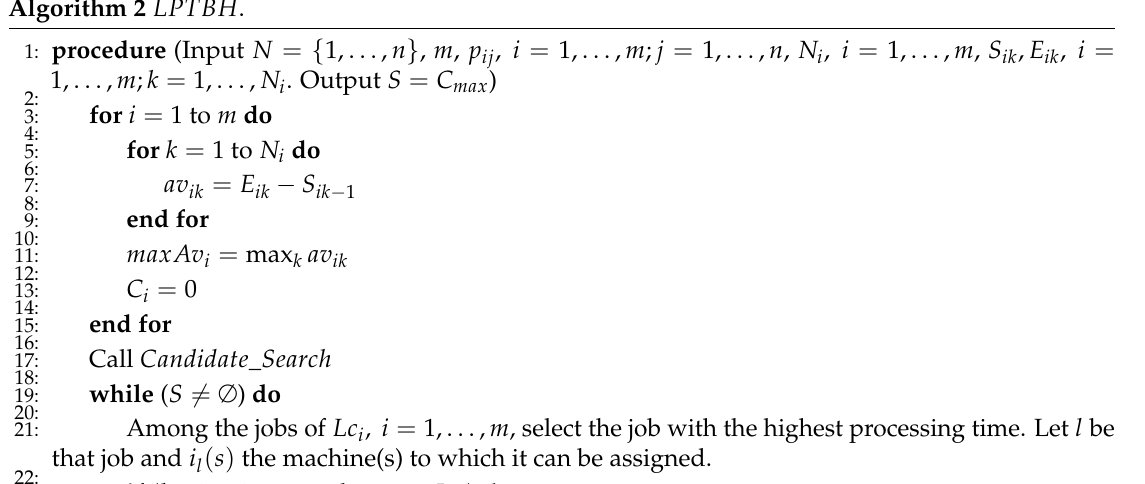
Algorithm 2 LPTBH